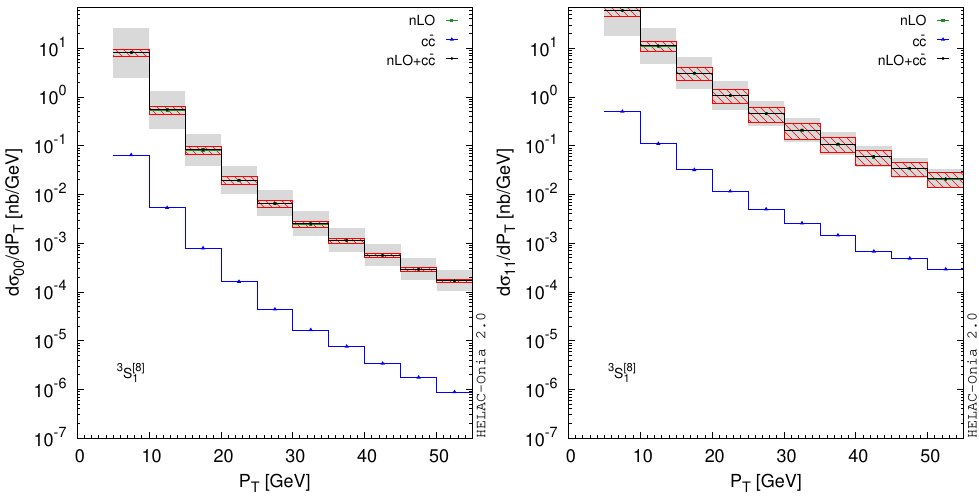
Figure 17 . Comparisons of spin-dependent differential cross sections d(cid:27) between our nLO calculations and the LO charmonium plus charm quark pair